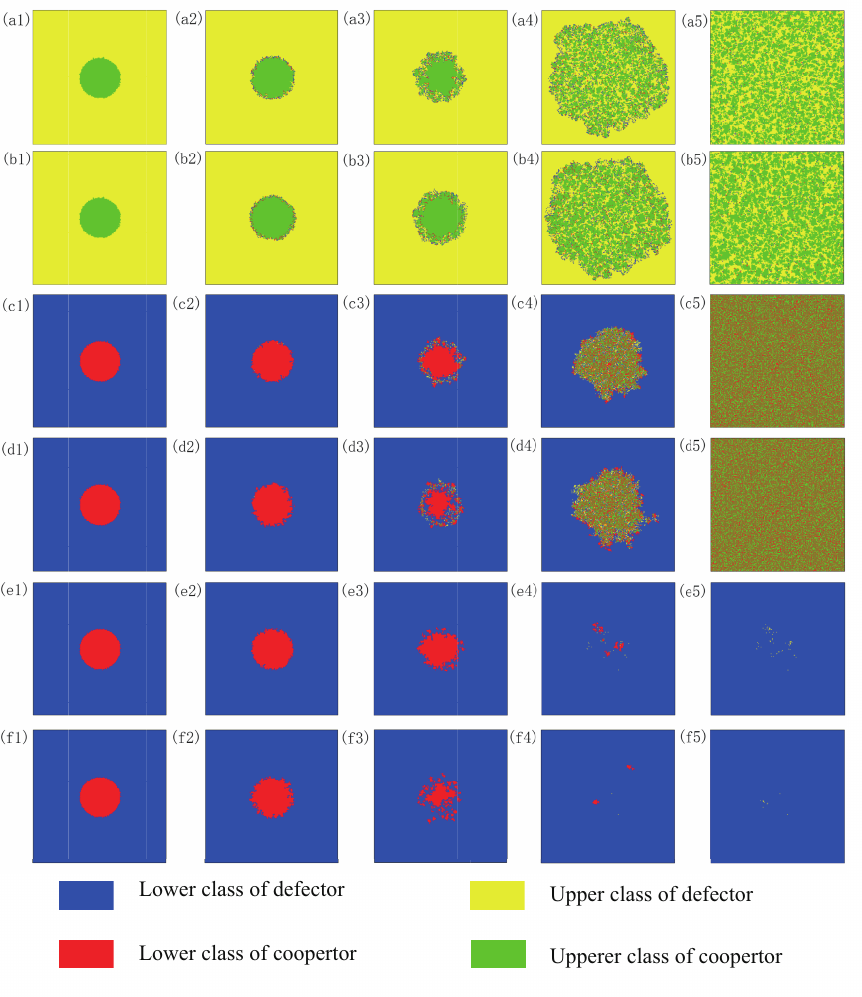
Figure 3. Feature snapshots of the strategies evolution when β = 0.5. Among these snapshots, we define a player whose influence exceeds the given influence threshold τ as upper class, otherwise the player is defined as lower class. Red and blue dots represent cooperators and defectors who are lower class, respectively, while green and yellow points indicate cooperators and defectors who are lower class, respectively. Furthermore, each two rows from top to bottom are grouped, that is, lines ( a1 – a5 , b1 – b5 ) are a group, lines ( c1 – c5 , d1 – d5 ) are a group, and lines ( e1 – e5 , f1 – f5 ) are a group. In addition, in each group, the upper lines are the snapshots of the network B (top), and the lower ones are the results obtained on network A (bottom). Moreover, for each group from top to bottom, the values of influence threshold τ correspond to 0, 8, and 40, respectively. For the columns from left ro right, the generations of MC are 0, 20, 100, 1000, and 50,000, respectively. Other parameters are exactly the same as those in Figure